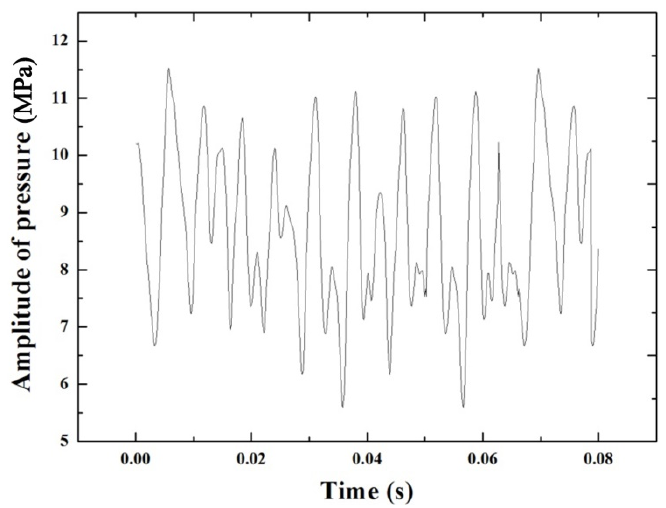
Figure 13. Dynamic pressure of the maximum point on stay vane vs. time.